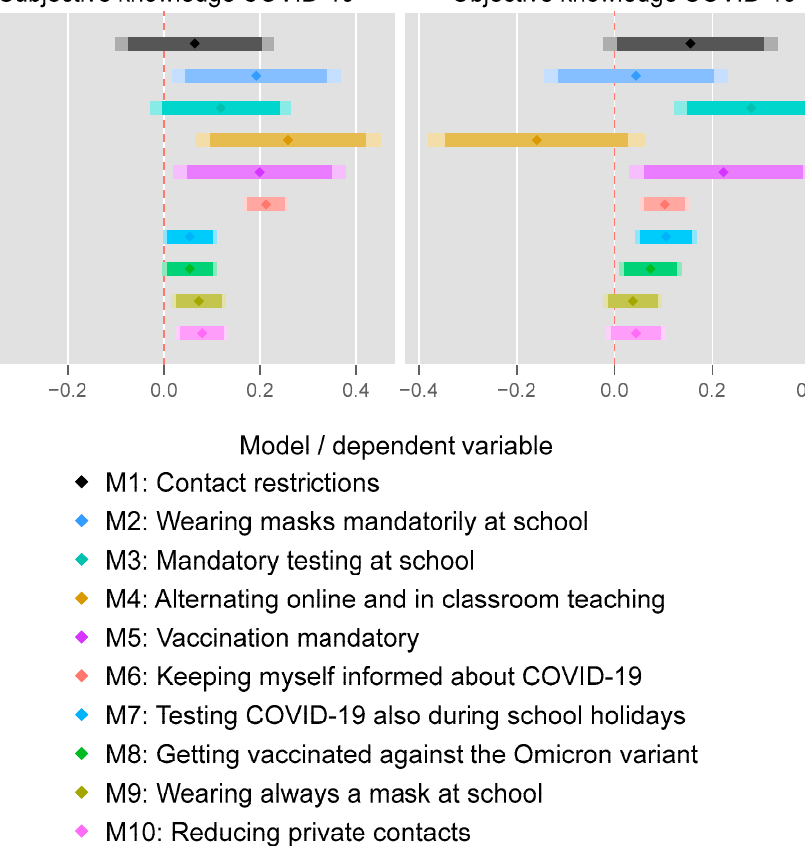
Figure 6. Effects of subjective and objective knowledge about the COVID-19 pandemic, shown with OLS regression (b-coefficients + 90% (darker colors) or 95% (lighter colors) confidence intervals).